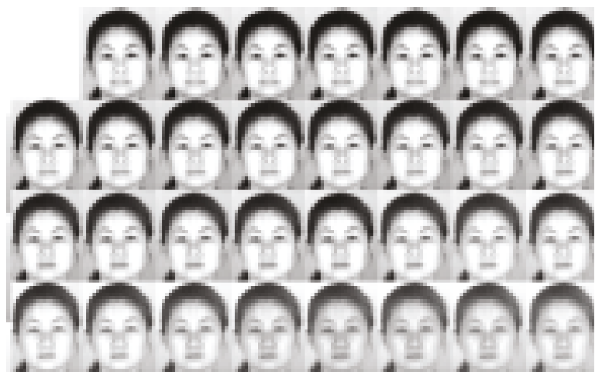
Figure 8: A sample image composed from 31 bands with low- spatial resolution.